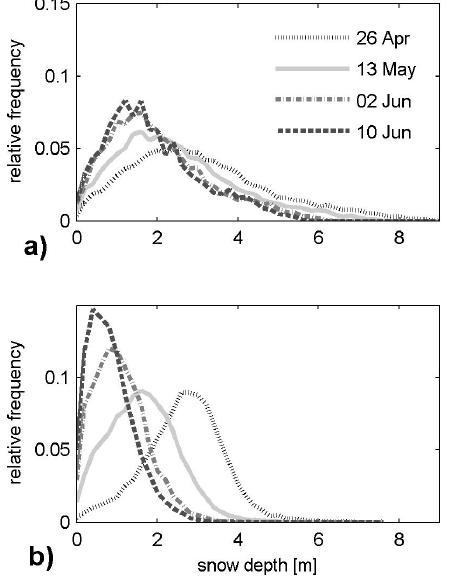
Fig. 6. Histograms of snow depth for the sub-areas NE (a) and SE (b) . Interval size for (a): 63, interval size for (b):